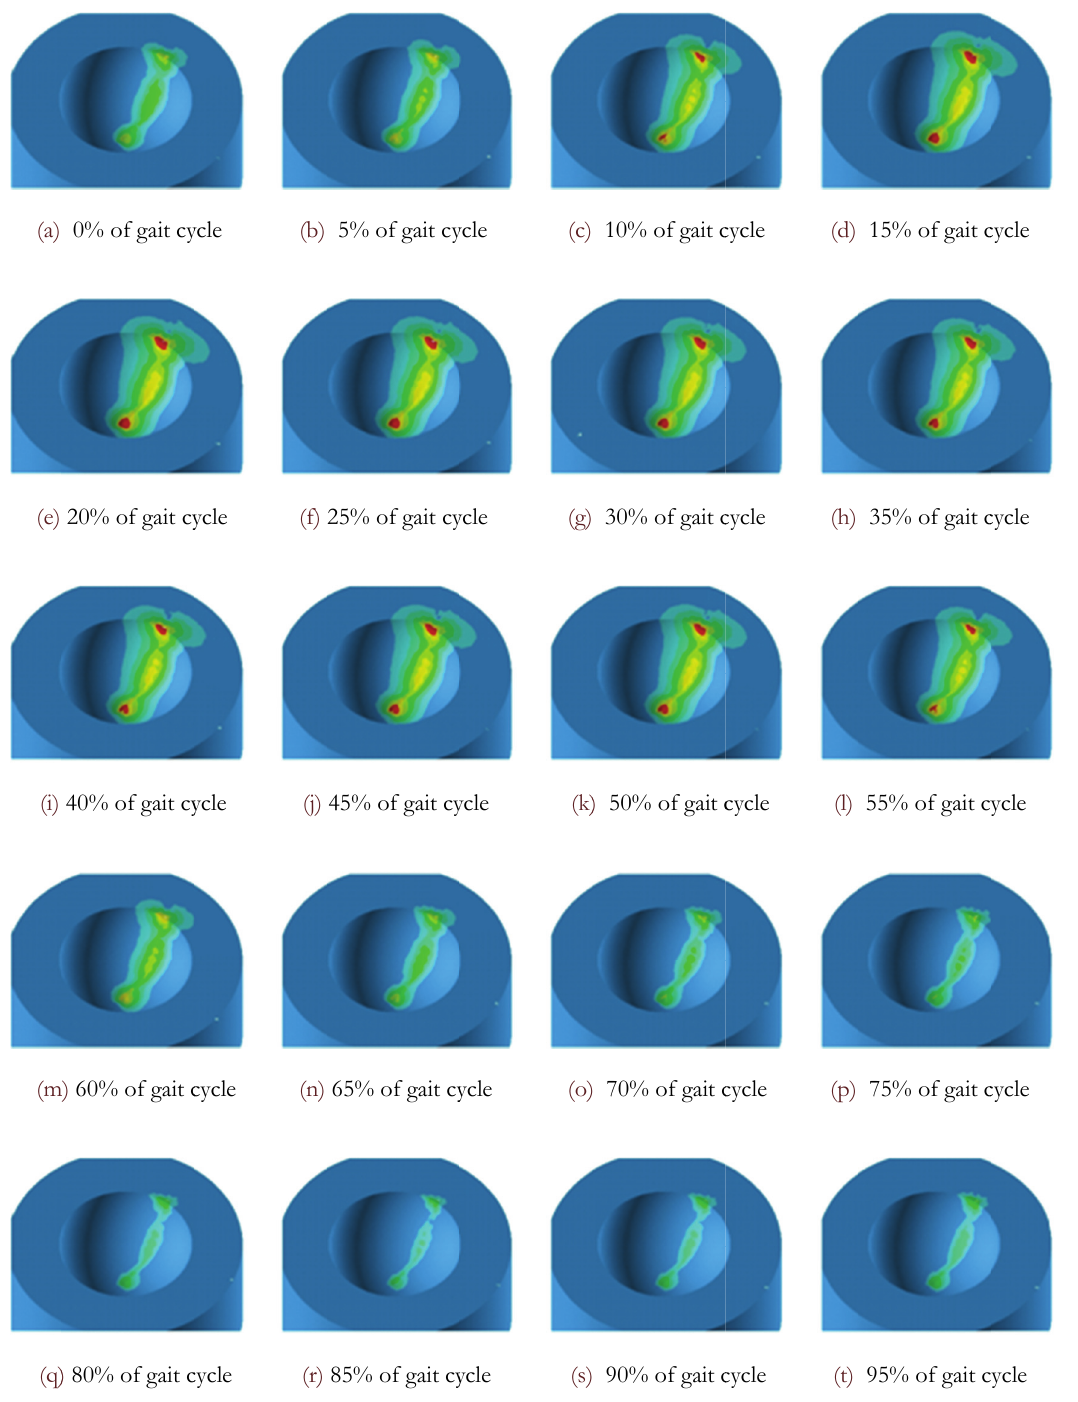
Mises stress ray source L8 (FPD) C7942 at each pixel maximal resol on exposed fo g 10 times 0.5